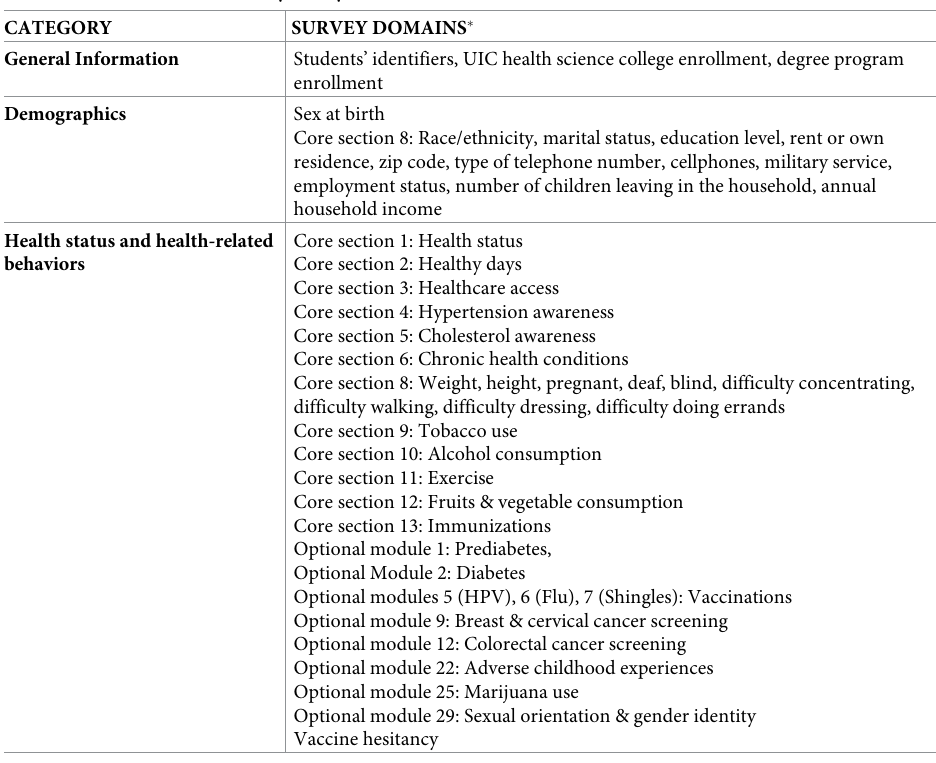
Table 3. HOLISTIC Cohort Study survey